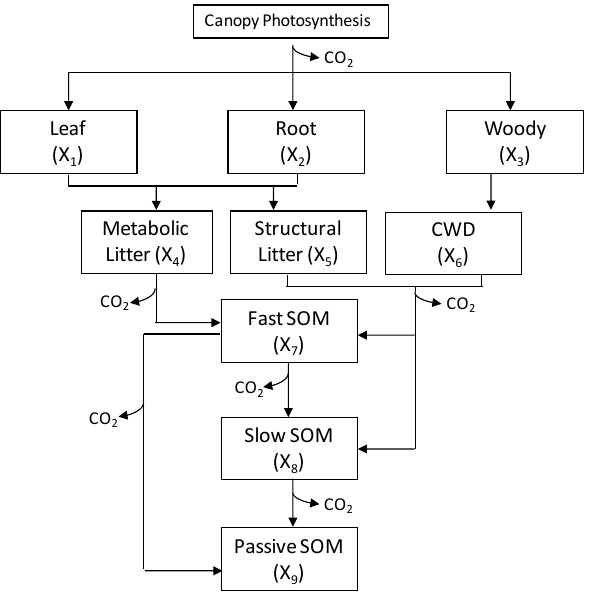
Figure 1. 710 Fig. 1. Diagram of the carbon processes of the CASACNP model on which Eq. (1) is based. SOM stands for soil organic